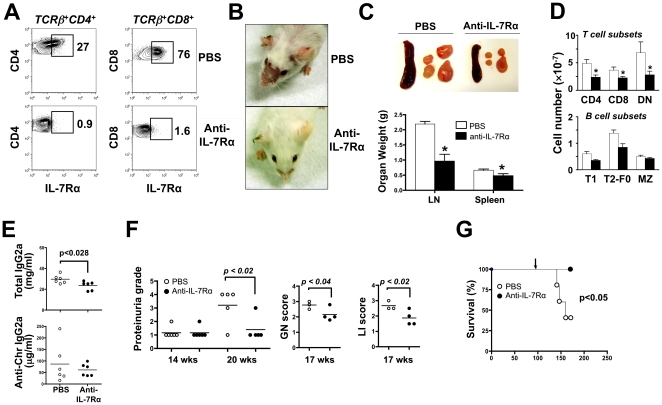
IL-7R blockade inhibits disease in MRL-Faslpr mice.(A) IL-7R blockade by anti-IL-7Rα antibody. MRL-Faslpr mice (6 weeks old) were treated with anti-IL-7Rα antibody or PBS, 3 times weekly for 4 weeks, and expression of IL-7Rα was determined. (B–E) Prophylactic anti-IL-7Rα antibody treatment. Young female MRL-Faslpr mice (6 weeks old) were treated with anti-IL-7Rα or PBS for 6 to 10 weeks. Antibody levels (E) were assessed after 6 weeks, dermatitis (B) after 8 weeks, and weights (± SD) of inguinal, axillary and cervical LNs and spleen (C) after 10 weeks of treatment. B and T cell subsets (D) were examined in LNs and spleen after 10 weeks of treatment. (F-G) Therapeutic anti-IL-7Rα antibody treatment. Female MRL-Faslpr mice (14 weeks old) with established disease (lymphadenopathy and anti-chromatin autoantibodies) were treated with anti-IL-7Rα or PBS for 3 to 10 weeks. Proteinuria, glomerulonephritis (GN) and lymphocytic infiltration (LI) were determined between 14 and 20 weeks of age (E), and survival at 24 weeks of age (F). Data are representative of 1–5 independent experiments with 3–9 mice/group.